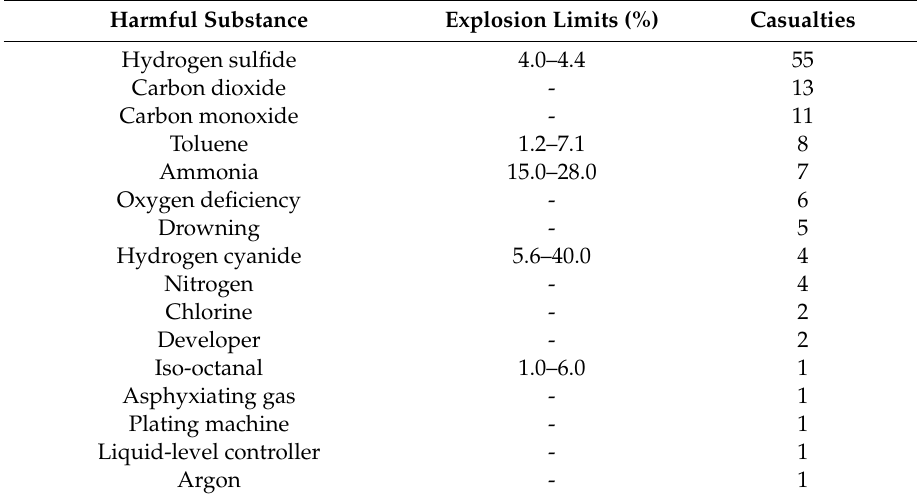
Table 3. Harmful substances involved in casualties caused by confined space examined in this study.